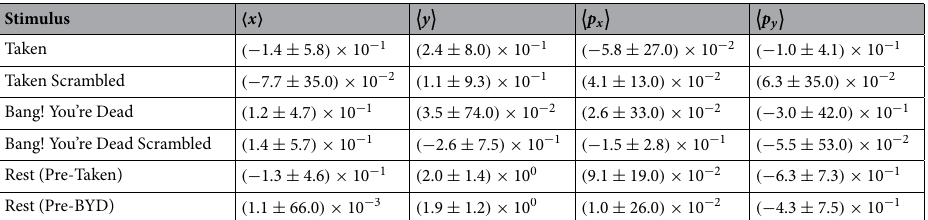
18 ± 29 cm 2 4 ms . The